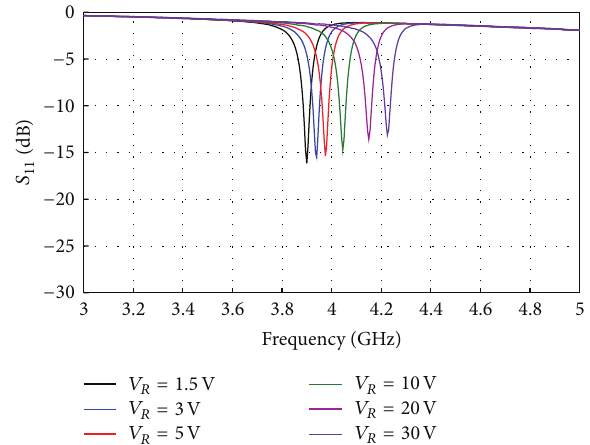
Figure 11: Measured reflection coefficient of the proposed tunable